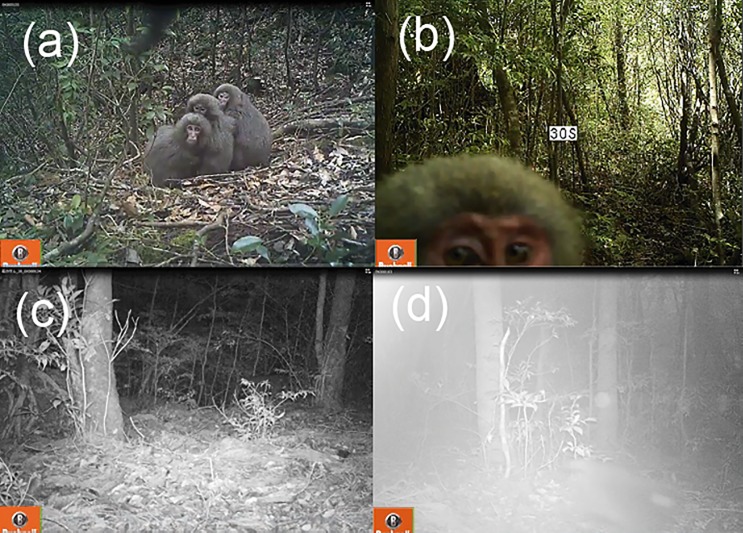
Examples of the movies of Japanese macaques taken by camera trapping in daytime (a and b) and nighttime (c and d). Still images were taken from the movies filmed at (a)17:01 on February 2015, (b)12:01 on August 5, 2014, (c) 1:30 on November 12, 2014, and (d) 18:30 on November 7, 2014.